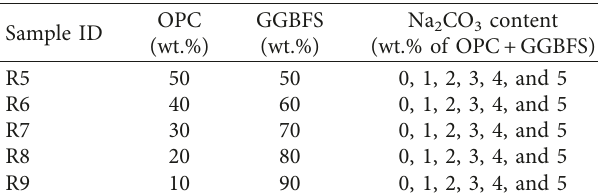
Figure 1: XRD spectra of the raw materials. Table 2: Mixture proportions in the test